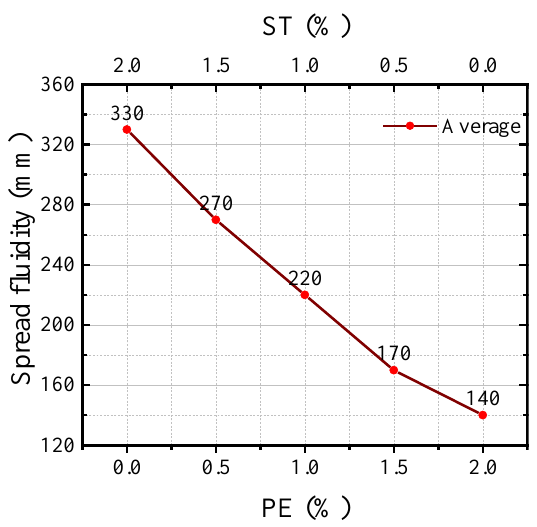
Figure 6. Spread fluidity of the freshly-mixed pastes of hybrid ultra-high performance (HUHP)-ECCs.